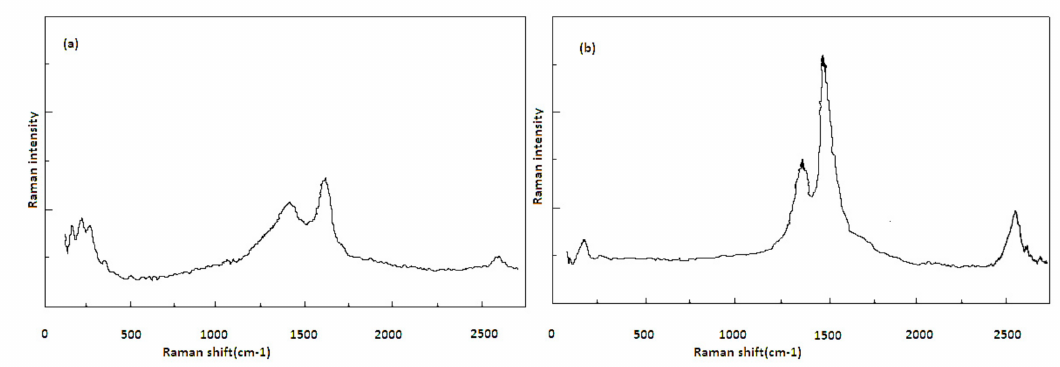
Figure 5. Raman spectra of the products using: ( a ) catalyst concentration = 5 wt %, hydrogen flow rate = 240 cm 3 /min, and temperature = 1100 ◦ C, ( I G /I D ) = 1.87 and ( b ) catalyst concentration = 5 wt %, hydrogen flow rate = 240 cm 3 /min, and temperature = 900 ◦ C, ( I G /I D ) =